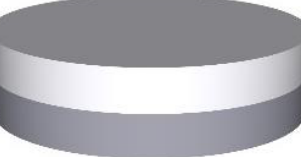
Figure 2. 3D visual design of overprinting tablet: diameter: 10 mm; top layer overprinted thickness: 1.8 mm; and bottom layer injection molded thickness: 1.8 mm.